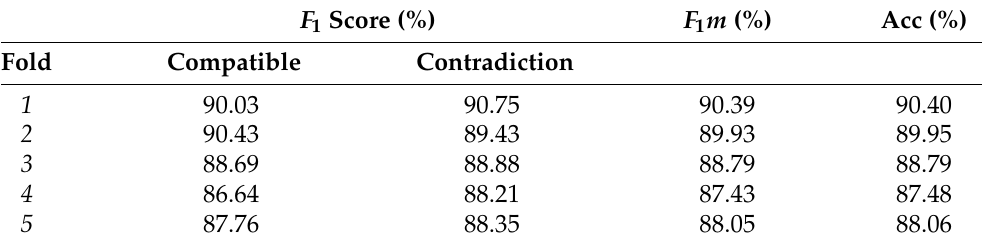
Table 4. Results obtained from Experiment 2: k-fold cross-validation.